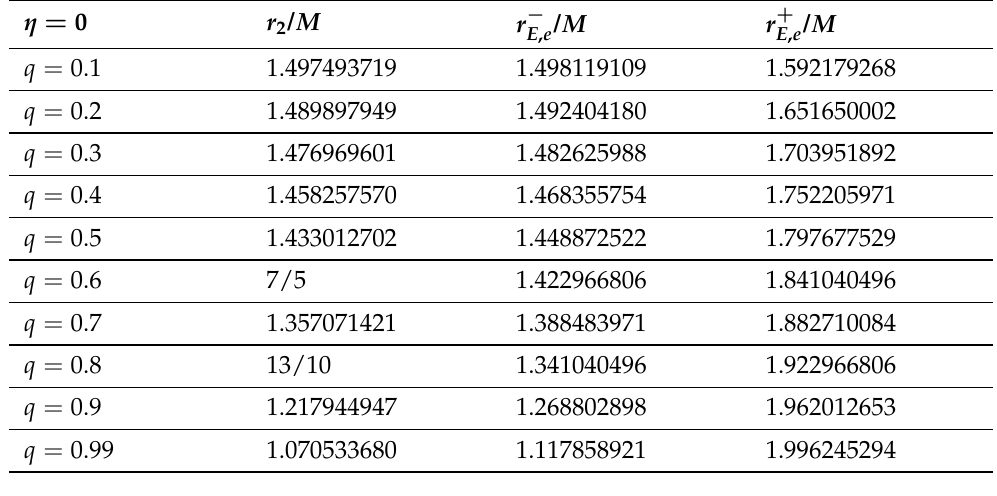
Table 2. Typical values of the horizon r 2 and the inner and outer boundaries of the ergoregion r ± the equatorial plane.